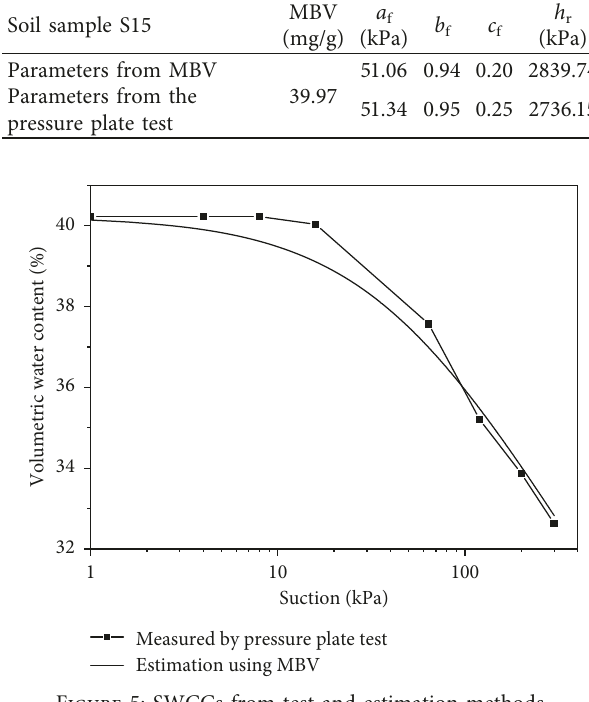
Figure 5: SWCCs from test and estimation methods.